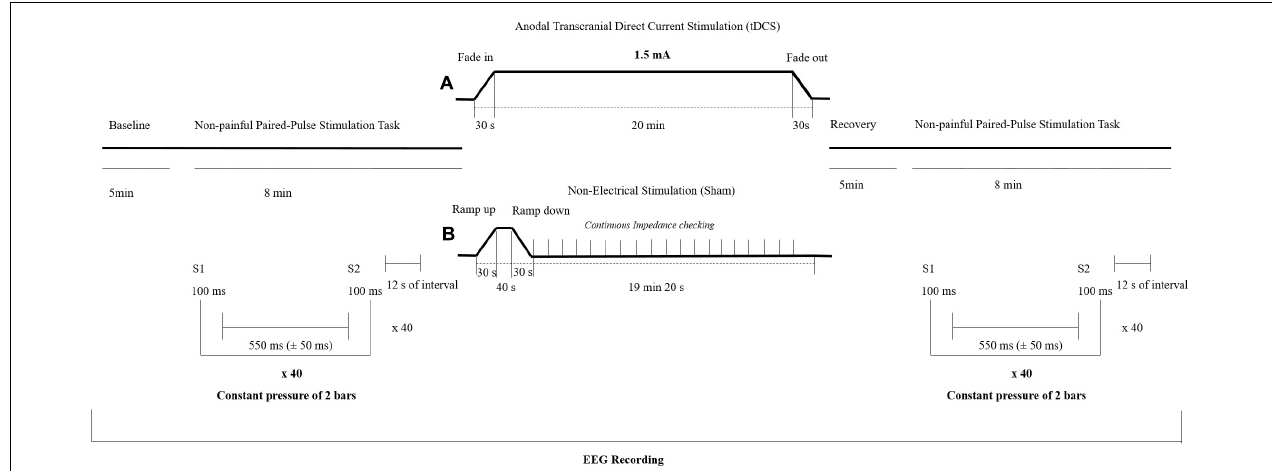
FIGURE 1 | Experimental design of the study. Participants were randomly assigned to either a transcranial direct current stimulation (tDCS) (A) or a SHAM group (B) . EEG = Electroencephalography.